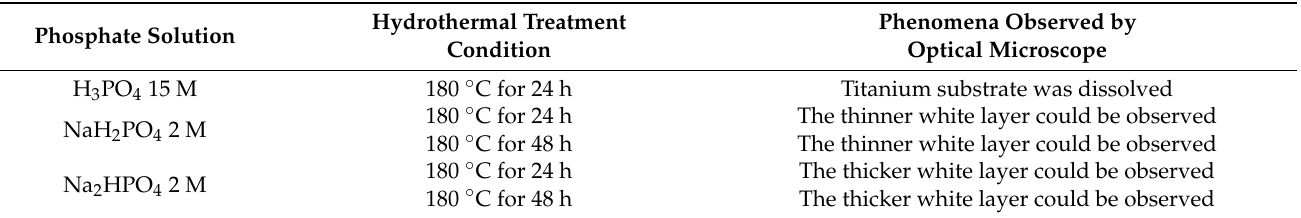
Figure 2. Optical microscopy images of ( a ) Ti bar and when hydrothermal treated at different phosphate solutions: ( b1 ) NaH 2 PO 4 2 M at 180 ◦ C for 24 h; ( b2 ) NaH 2 PO 4 2 M at 180 ◦ C for 48 h and ( c1 ) Na 2 HPO 4 2 M at 180 ◦ C for 24 h; ( c2 ) Na 2 HPO 4 2 M at 180 ◦ C for 48 h. The black arrows indicate Ti substrate, while the white arrows indicate the coating layer. Table 1. Phenomena observed when Ca–O–Ti bars were immersed into 3 kinds of phosphate solutions at 180 ◦ C for different hydrothermal treatment